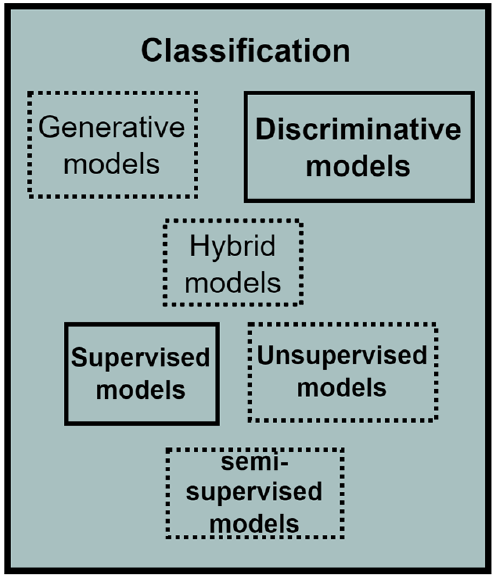
Figure 6. The Expanded Classification Component.